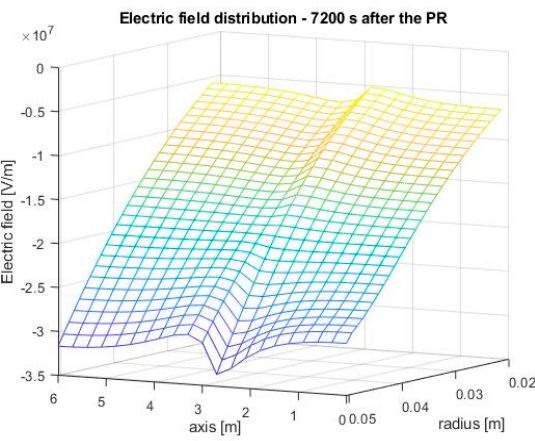
Figure 13. Electric field distribution 600 s after the end of the PR ramp—Scenario E.